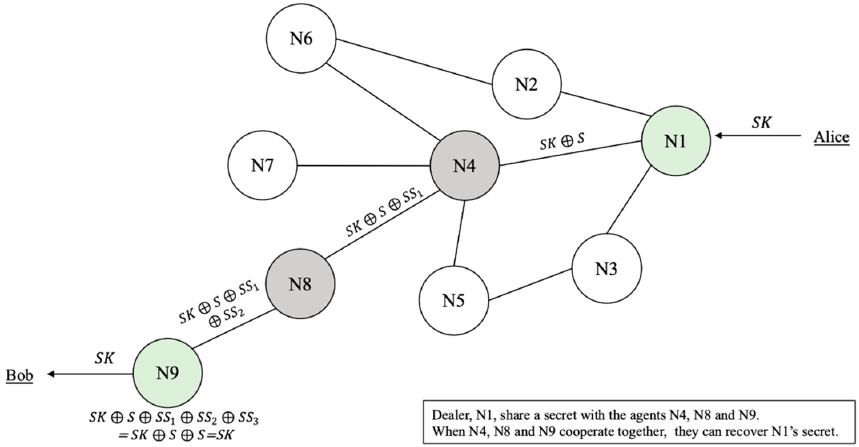
Figure 8. Session key transmission method using quantum secret sharing (QSS).